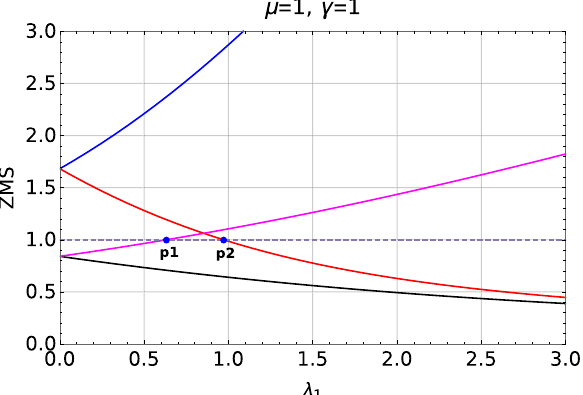
Figure 2. Zero mode solutions plotted with respect to the parameter (cid:31) 1 shows both W = 0 to W = 1 ( (cid:31) 2 = 0.5 ) and W = 1 to W = 2 ( (cid:31) 2 = 2.0 ) topological phase transitions. The red dot (p1 and p2) represent the transition points. The ZMS, X + (red) and X − (blue) are plotted in y-axis.